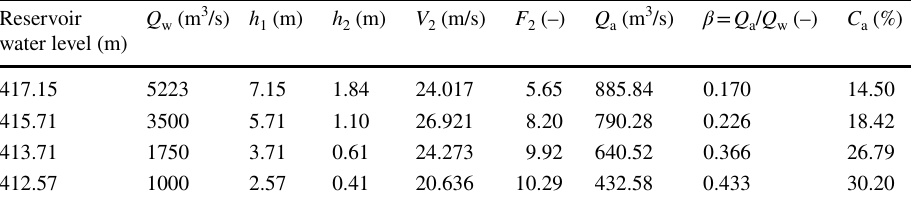
Table 4 Aeration performances obtained from numerical simulations for different weir discharges